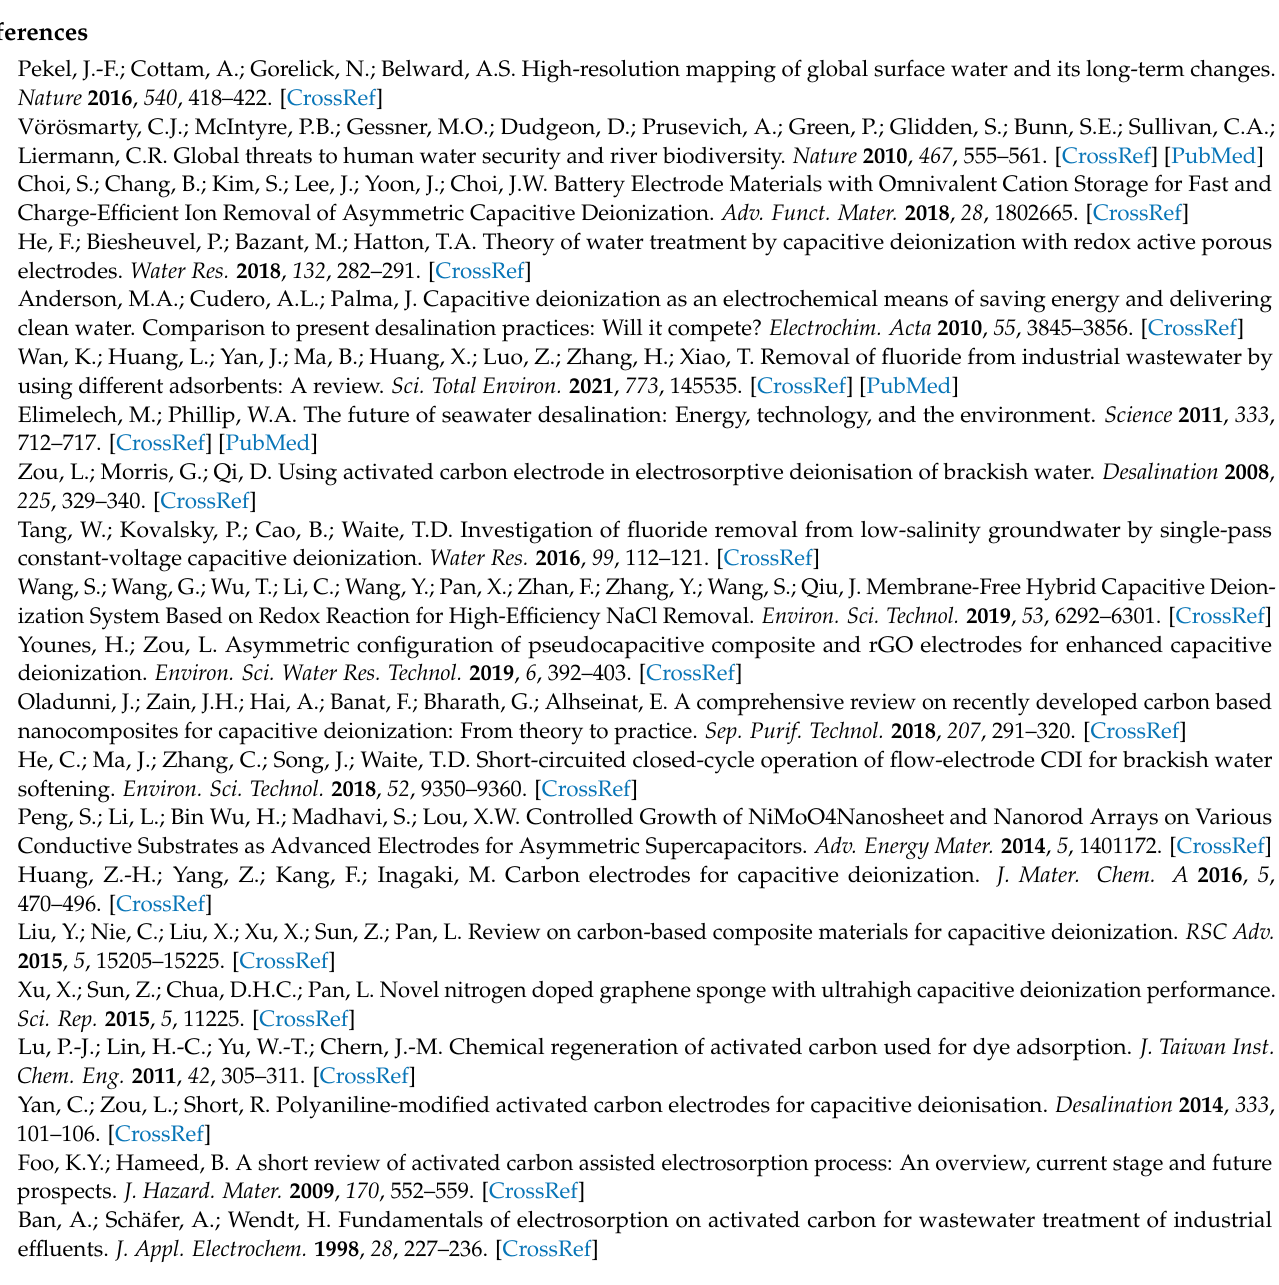
10.3390/mi12101148/s1, Figure S1: TEM images of the AC/ Fe 2 O 3 nanocomposite; Figure S2: N 2 adsorption-desorption isotherm, and pore size distribution curve of the AC/ Fe 2 O 3 nanocomposite; Figure S3: Water contact angel with the function of the contact time for the AC; Figure S4: Regen- eration profile for the AC/Fe 2 O 3 electrode; Table S1: XRD analyses of the fabricated AC/Fe 2 O 3 nanocomposite (Fe 2 O 3